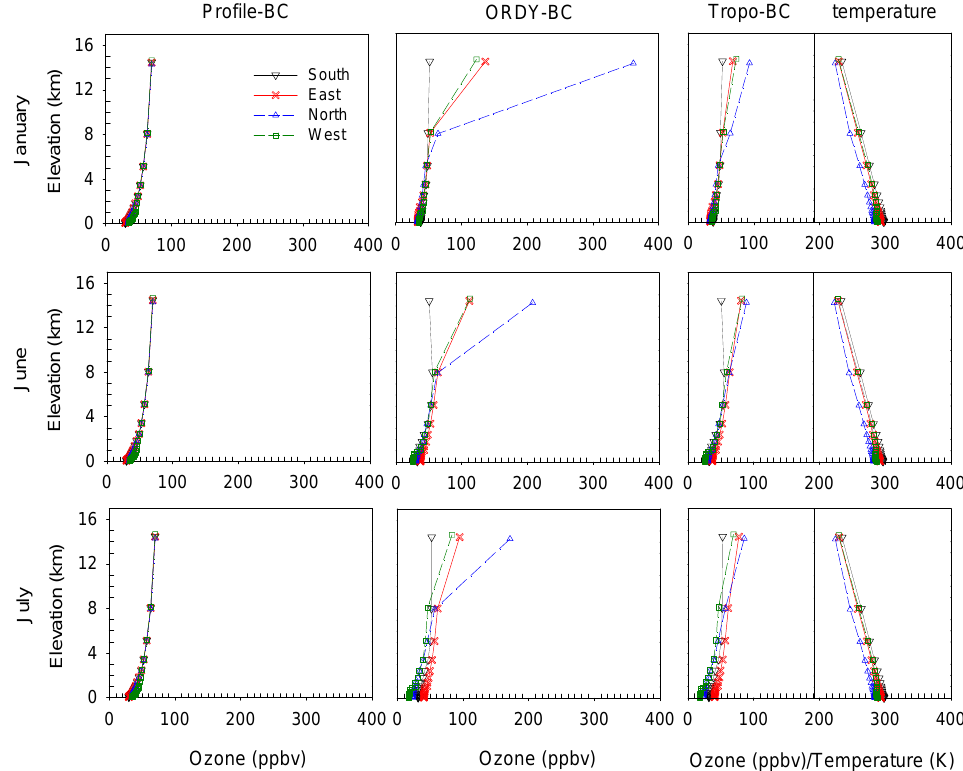
Fig. 7. Monthly vertical distribution of ozone from CMAQ BCs: South (black line), East (Red line), North (blue line), and West (green line) of CONUS domain in January, June and July with temperature profiles for Profile-BC (left), ORDY-BC (middle) and Tropo-BC (right).